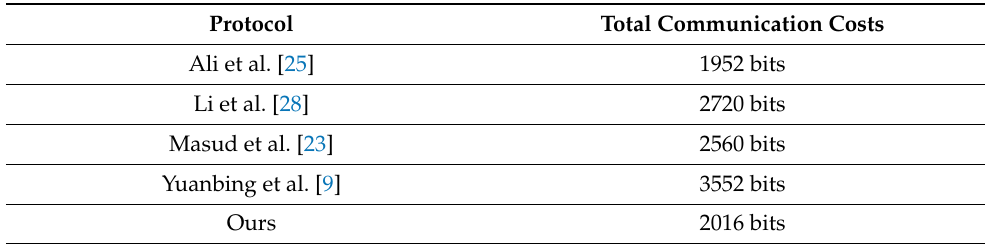
Table 4. Communication costs at login and authentication